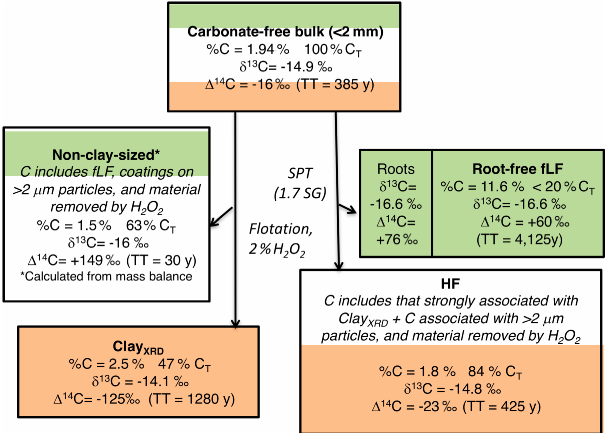
Figure 4. Comparison of C and C isotopes for a single soil sam- ple (0–3cm depth in GA-740-C (gabbro parent material) indicating the interrelationships among the different process-defined organic C fractions. For each fraction we indicate the percent of total C (C T ) it contains; fractions for root-free fLF and HF do not add to 100% because of contributions from roots picked from the free light frac- tion (fLF) and C that dissolves in the polytungstate solution and is not recovered. Colors indicate overlaps between C among differ- ent fractions that exist. For example, C strongly associated with the clay-sized fraction measured with XRD (Clay XRD ; orange) makes up part of the HF C. Free low-density C (fLF; green; including both roots picked from the fLF and the root-free fLF fractions) makes up part of the non-clay-sized fraction. Most of the fLF is likely re- moved from the Clay XRD when it is treated with 2% H 2 O 2